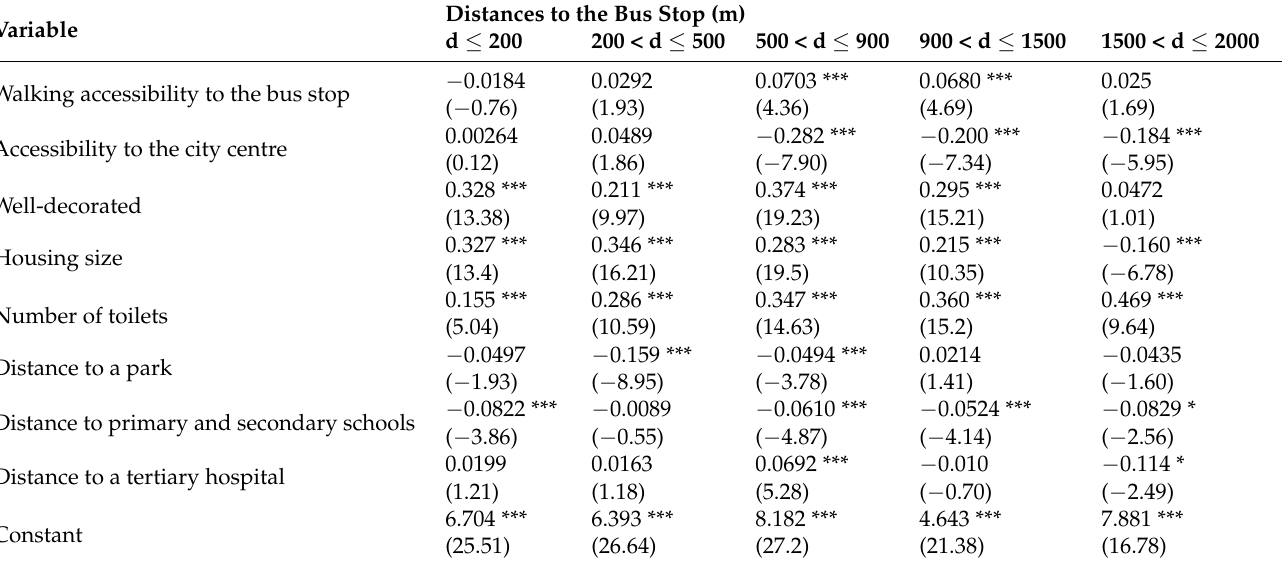
Table 5. OLS regression results of bus stop neighbourhood